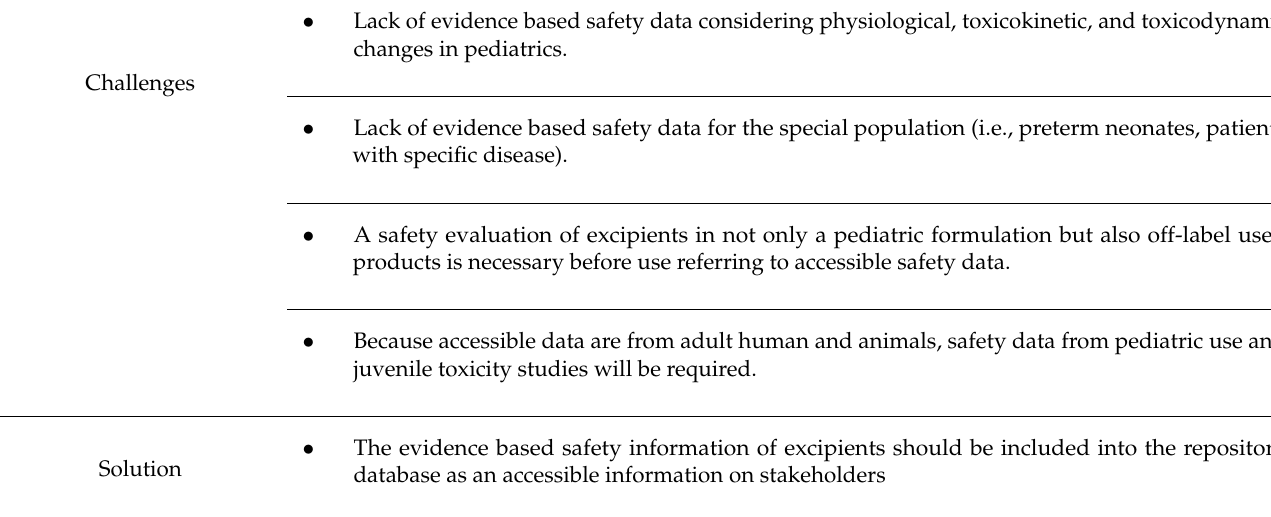
Table 3. Safety issues on pharmaceutical excipients for pediatric